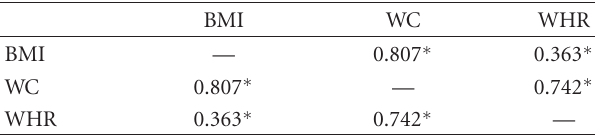
Table 2: Prevalence of metabolic syndrome and the components of metabolic syndrome in postmenopausal women.